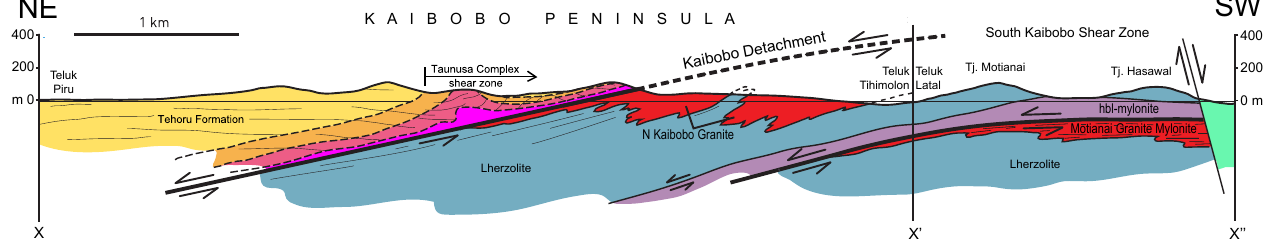
Fig. 6. Cross section X–X 0 –X 00 across the Kaibobo Detachment and South Kaibobo Shear Zone, Kaibobo Peninsula. See geological map in Fig. 5 for location and key to